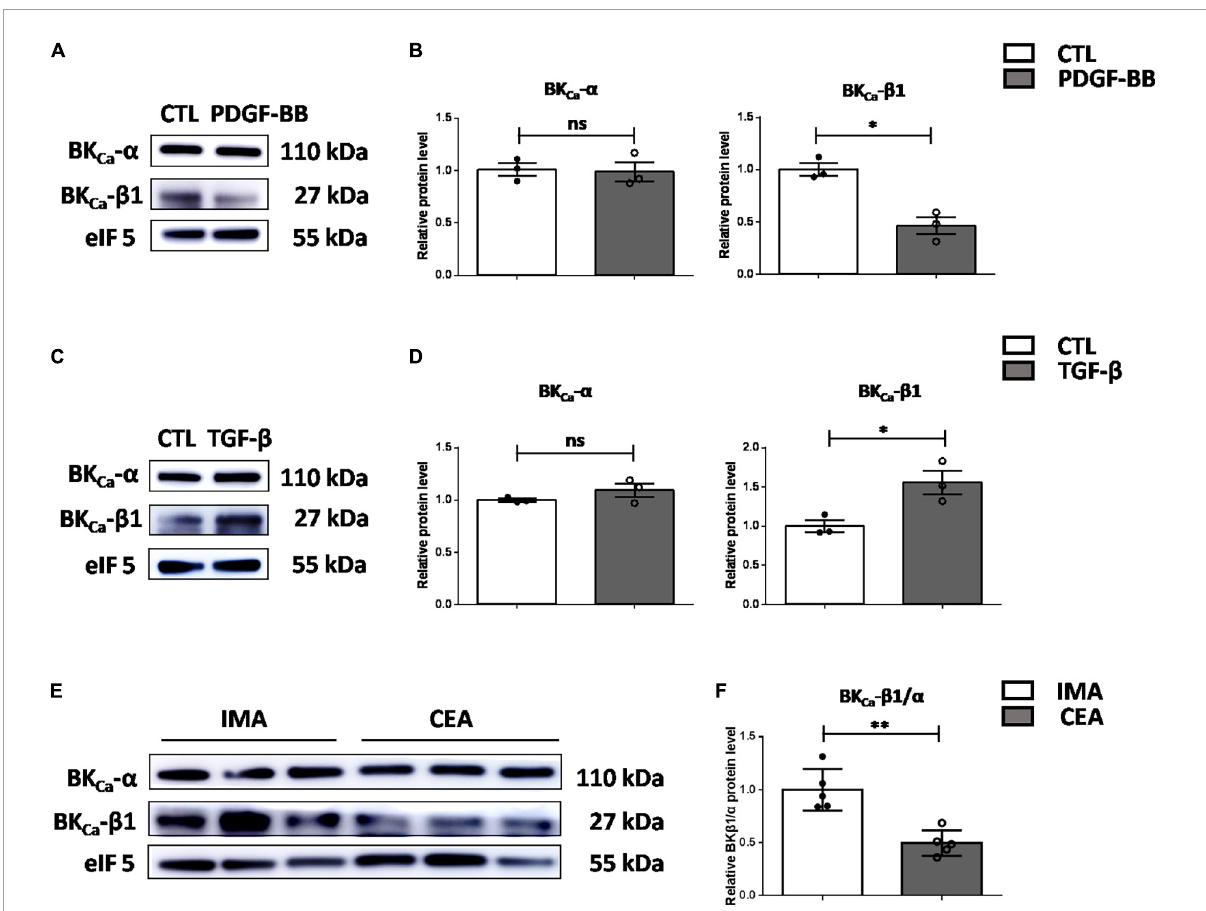
FIGURE6 Decreased BK ca − β 1 expression is correlated with VSMC dedifferentiation and atherosclerosis in human. Western blot images (A) and quantification (B) of BK ca − α and BK ca − β 1 expression in human primary aortic VSMCs after PDGF-BB treatment (25 µ g/L). Western blot images (C) and quantification (D) of BK ca − α and BK ca − β 1 expression in human primary aortic VSMCs treated with TGF- β (2.5 µ g/L). VSMCs were subjected to serum-starvation for 24 h and then treated with the indicated stimulation for 48 h. Passages 3–5 of VSMCs were used. (E) Representative western blot images of the protein levels of BK ca − α and BK ca − β 1 in lysates of human carotid endarterectomy artery (CEA) and control internal mammary arteries (IMA). (F) Quantification was performed by calculating the ratio between the levels of BK ca − β 1 and BK ca − α . Eukaryotic initiation factor 5 (eIF5) was used as an internal control. Data are presented as means ± SEM (n = 3 ∼ 5 for each group, ns, not significant, * P < 0.05, ** P < 0.01 vs.